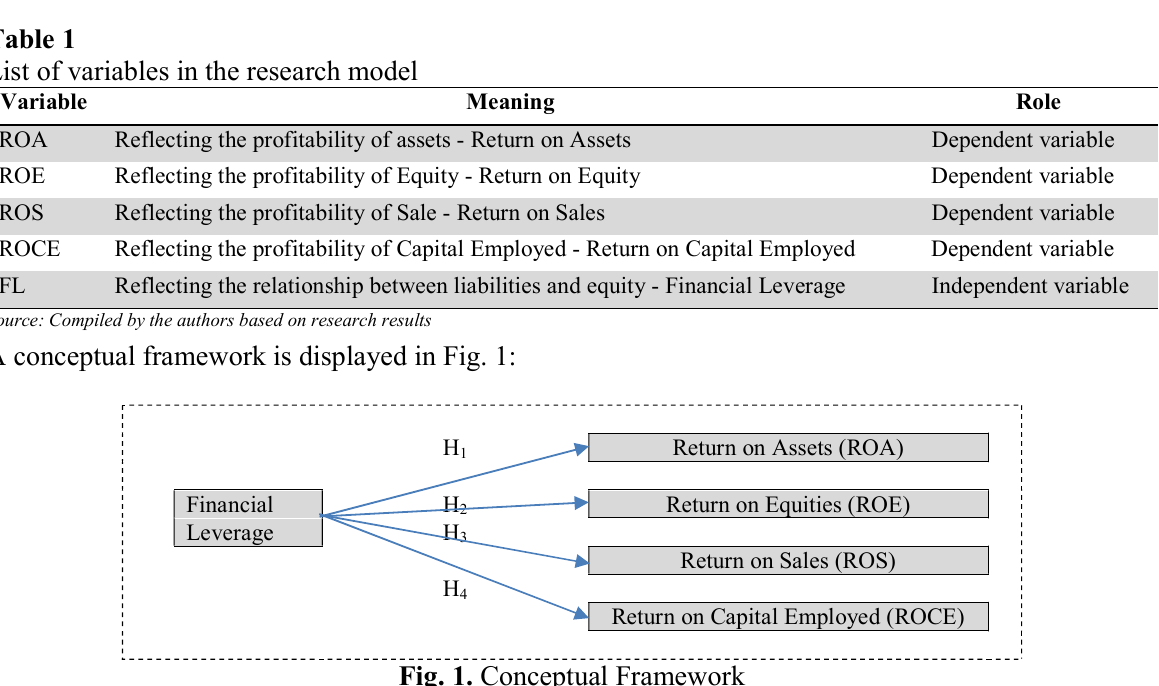
Fig. 1. Conceptual